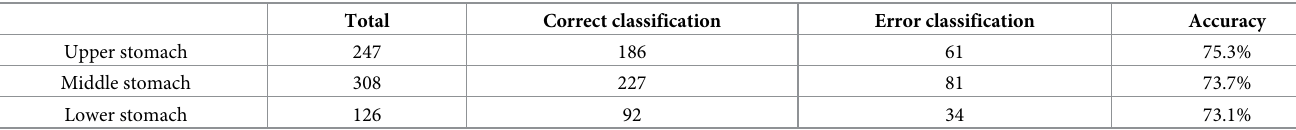
Table 2. Results for stomach classification.